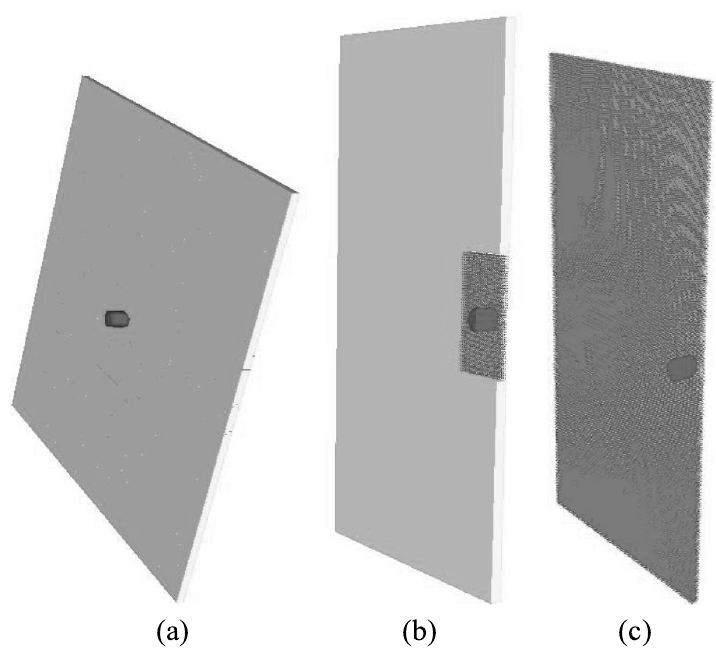
Fig. 1. (a) Finite element mesh, (b) finite element/particle mesh, and (c) particle